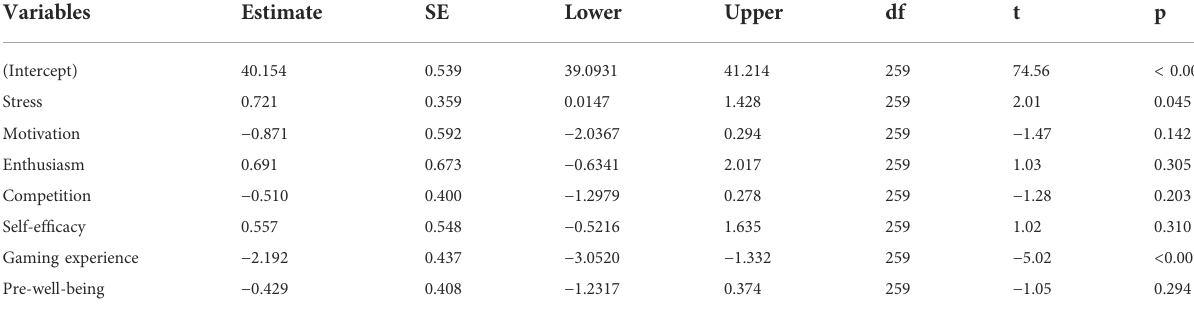
TABLE 5 Estimates of the relationships between age/experience and the learner ’ s state of